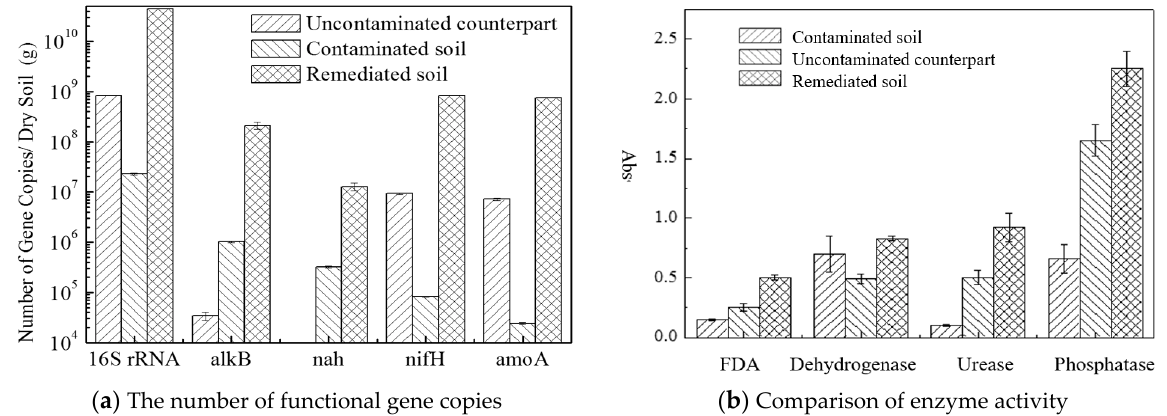
Figure 6. Changes in functional genes and enzyme activities during biodegradation.